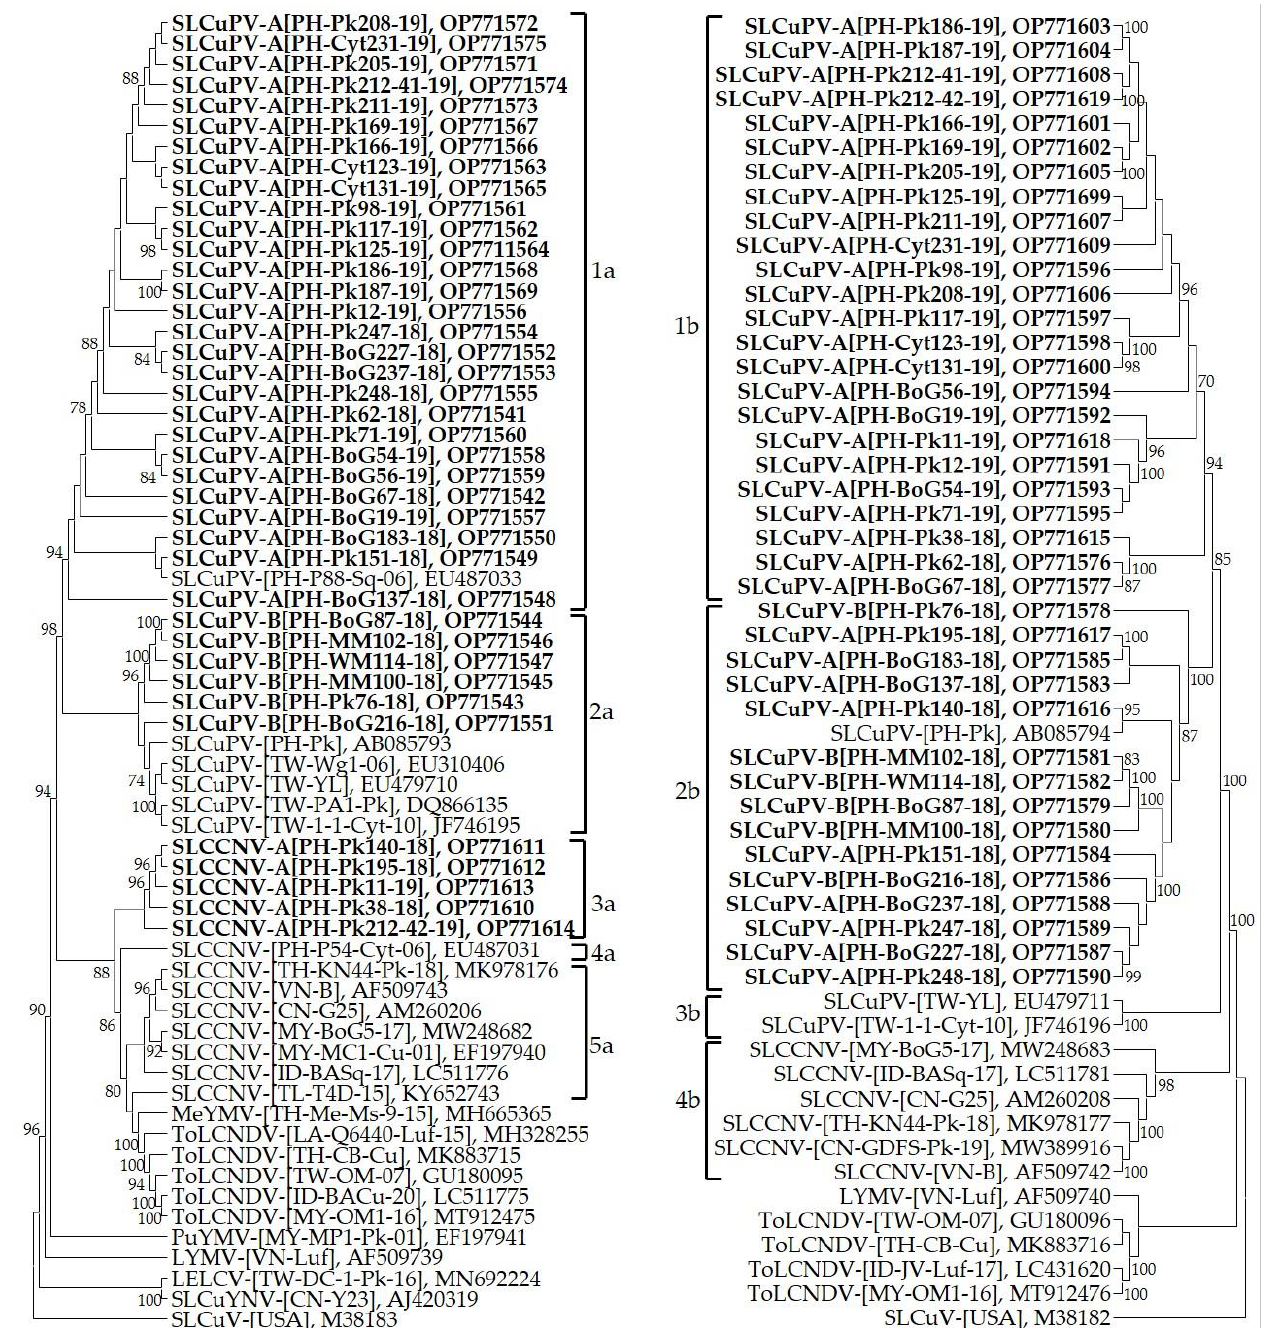
Figure 1. Phylogenic tree obtained from the alignment of complete DNA-A ( left ) and -B ( right ) nu- cleotide sequences of cucurbit-infecting begomoviruses. The sequences used for analysis including those newly identified in this study (in bold) and listed in Table S2. Both phylogenic trees were rooted on Squash leaf curl virus (SLCuV). The numbers of each branch indicated the percentage of 1000